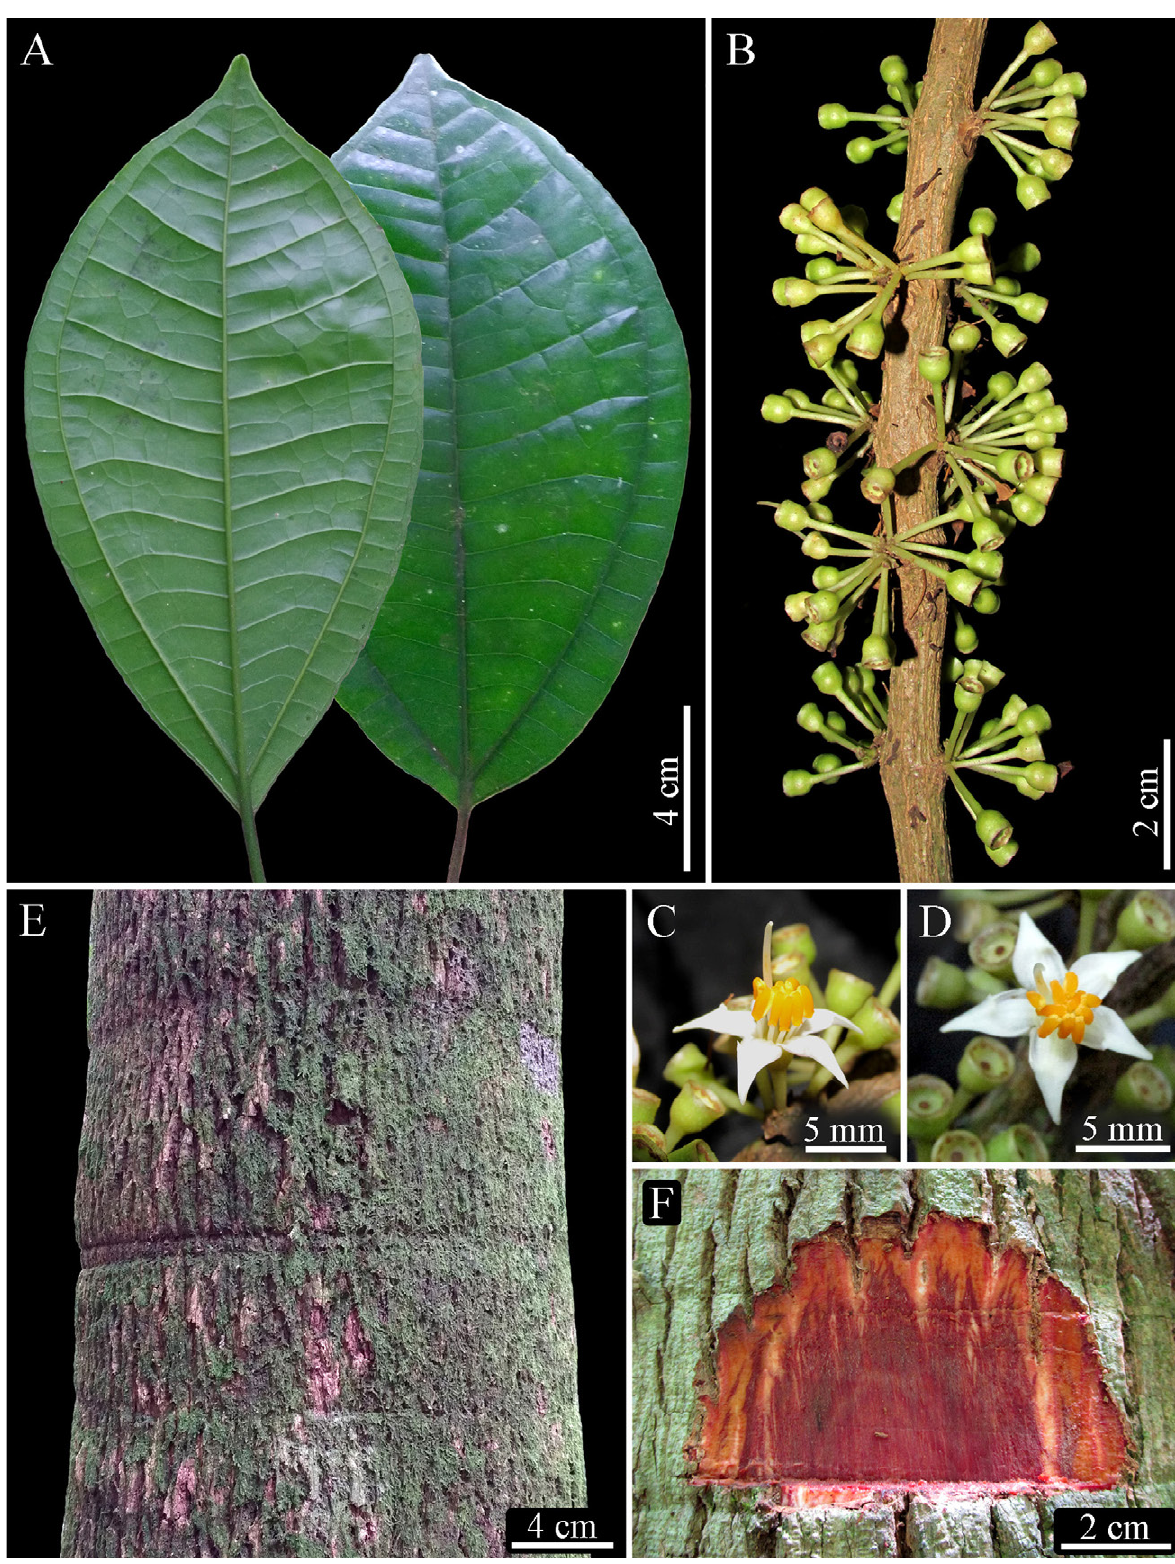
Figure 5. Henriettea glabra (Vell.) Penneys, Michelang., Judd et Almeda. A. Abaxial and adaxial leaf surfaces. B. Branch with immature fruits in the initial stage of development. C. Flower. D. Flower. E. Bark appearance. F. Slash